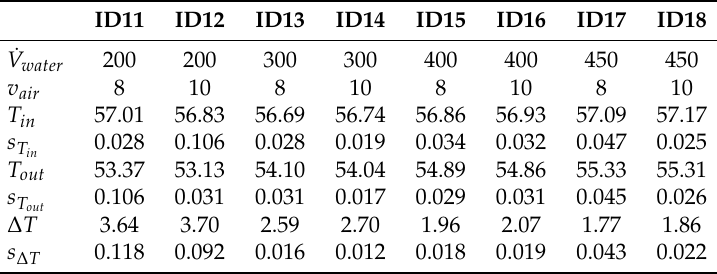
Table 5. Results of measurement in position B.